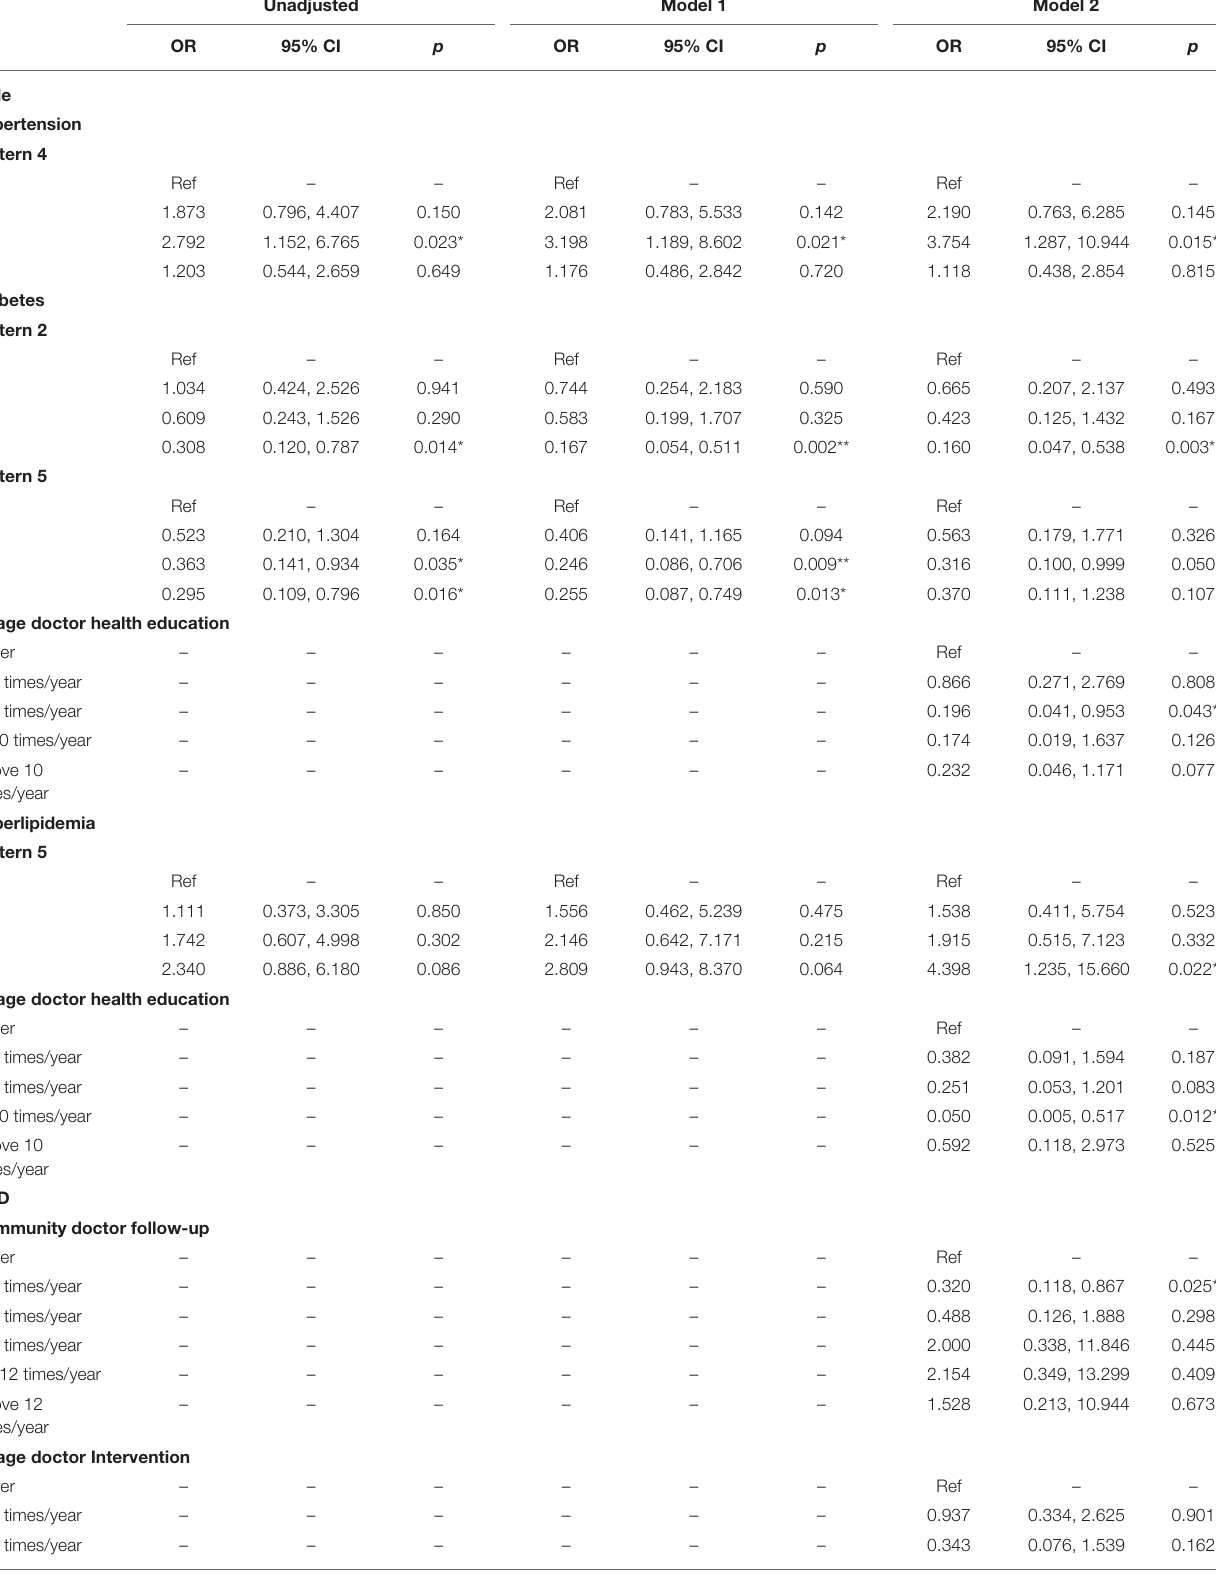
TABLE 7 | Factors contributing to different chronic diseases across sex